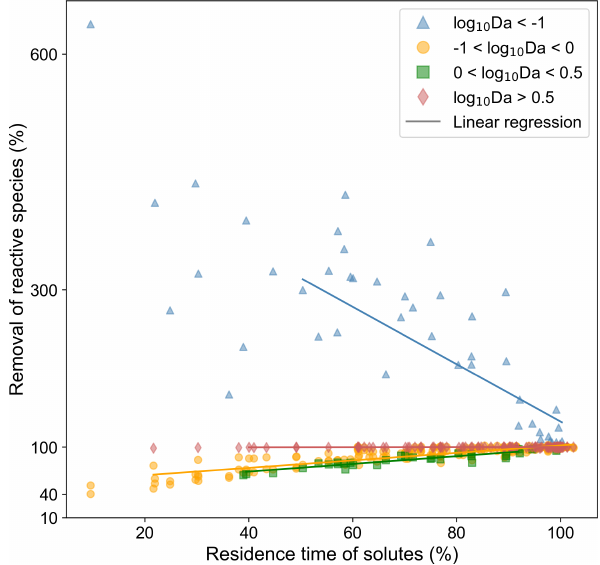
Figure 6. Regression analysis: predicting impact of spatial het- erogeneity on chemical species removal in the different reaction regimes indicated by log 10 Da . Value on the y axis indicate the re- moval of chemical species in heterogeneous domains normalized by that in the corresponding base case. Spatial heterogeneity is plotted on the x axis, indicated by the breakthrough time in the heteroge- neous domain normalized by that in the base case (homogeneous domain). A value of 100% on the y axis indicates that the removal of the chemical species is the same as that in the corresponding base case (homogeneous domain). A value of 50% indicates that the removal of the chemical species was reduced by half in the cor- responding heterogeneous domain. A value of 600 indicates that the removal of the chemical species in the heterogeneous domain was 6 times that in the homogeneous